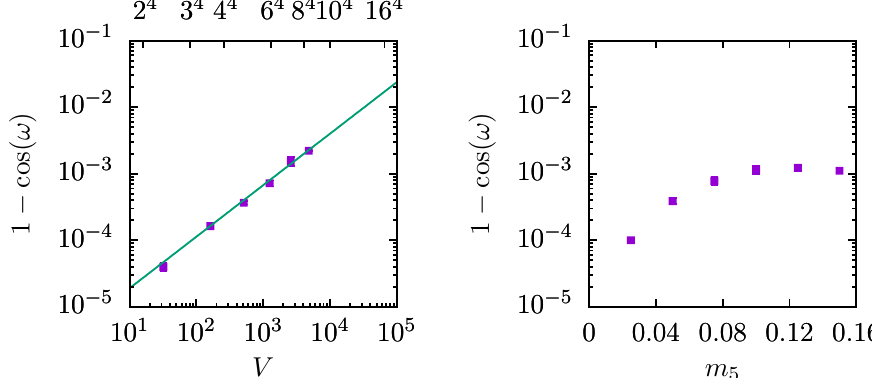
Figure 16 . Left: phase of the Pfaffian for different lattice sizes ranging from 2 3 × 4 to 7 3 × 14 . The green line is an exponential fit to extrapolate the results to the lattice size 16 3 × 32 . Right: phase of the Pfaffian for different values of m 5 ∈ [0 , 0 . 15] . When approaching the critical point at m 5 = 0 , the phase of the Pfaffian decreases. Error bars are mostly smaller than the symbol